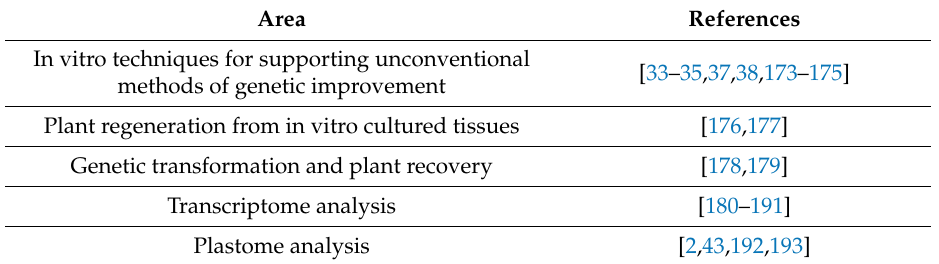
Table 5. Precision breeding approaches and breeding innovations in Olea